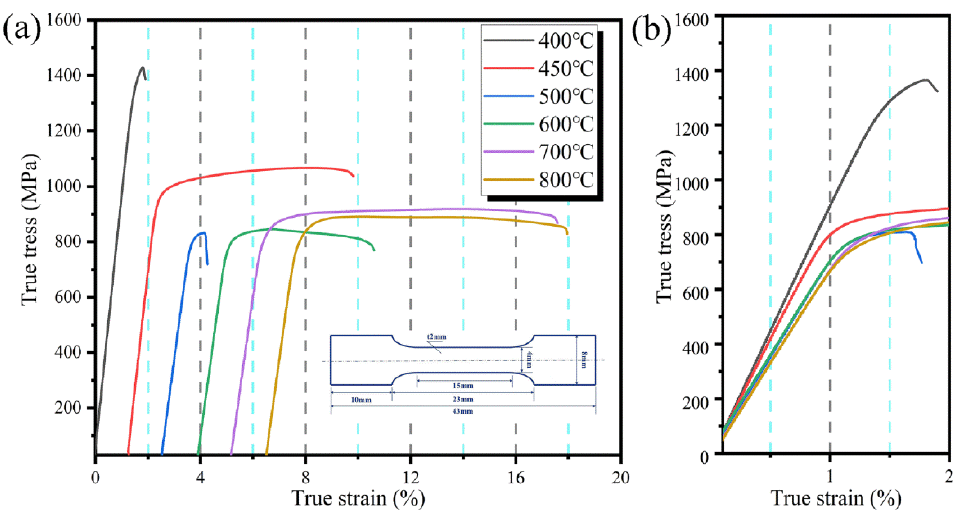
Figure 5. ( a ) True stress – strain curve and ( b ) elastic-deformation-stage true stress – strain curve of annealed Zr – Ti – 8V alloys. Table 1. Yield strength, compressive strength, elastic modulus, and elongation after fracture of the annealed Zr – Ti – 8V alloys.